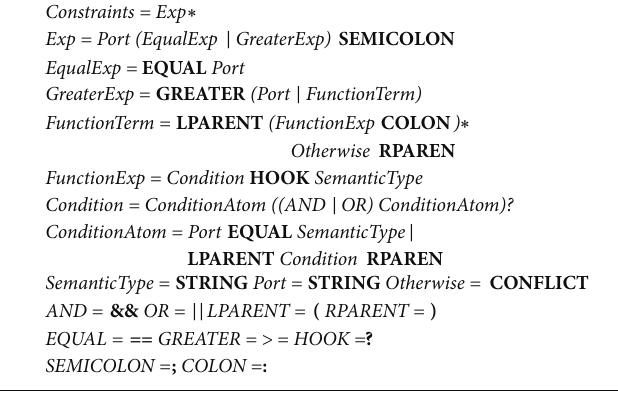
Figure 4: The Abstract Syntax of CDL.